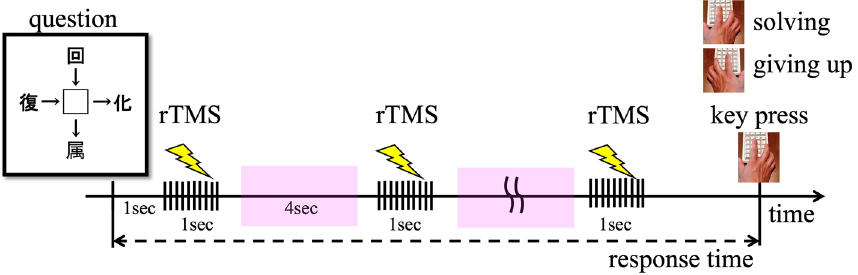
Figure 1. Experimental design. Seven seconds from the onset of keypress. The pink rectangles indicate the time window when participant’s averaged EEG amplitudes were